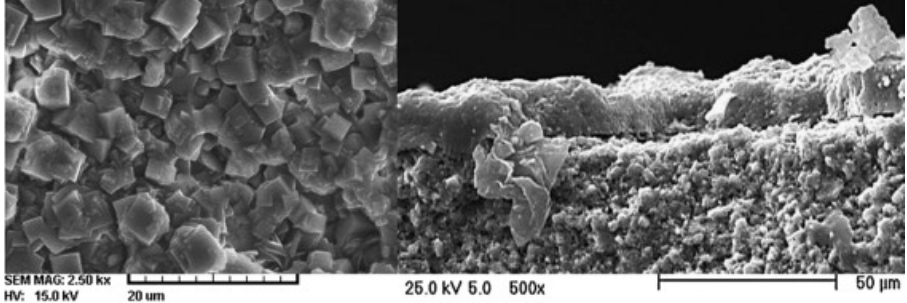
Figure 8. SEM photographs taken from surface and cross section of the membrane. Reprinted with permission from Ref. [99]. 2014, Elsevier.